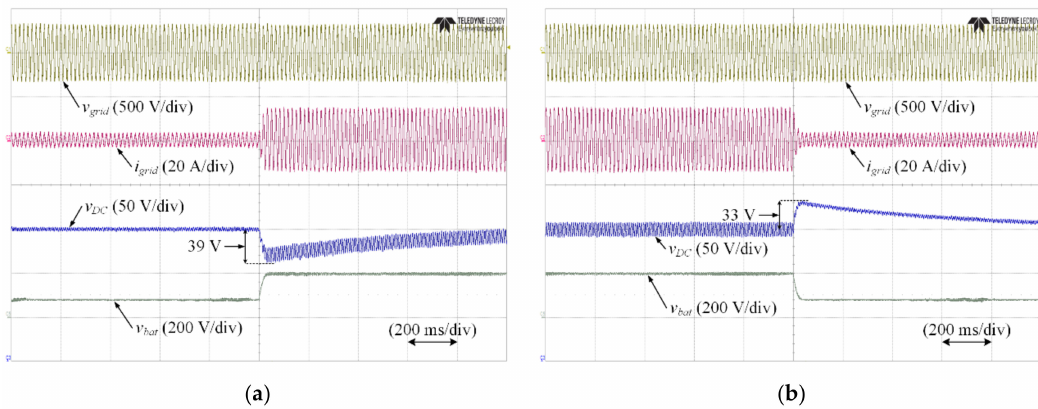
Figure 17. Experimental results of integrated OBC without proposed feed-forward control method in case the power of the battery-side is abruptly changed: ( a ) i bat is changed to 10 A from 4 A; ( b ) i bat is changed to 4 A from 10